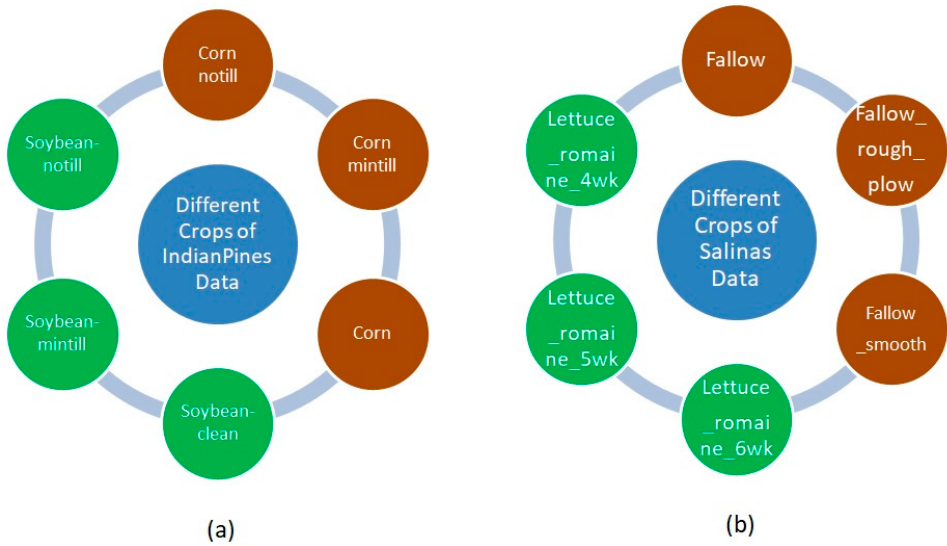
Figure 4. Different crops of AVIRIS Sensor data ( a ) Indian Pines ( b ) Salinas.